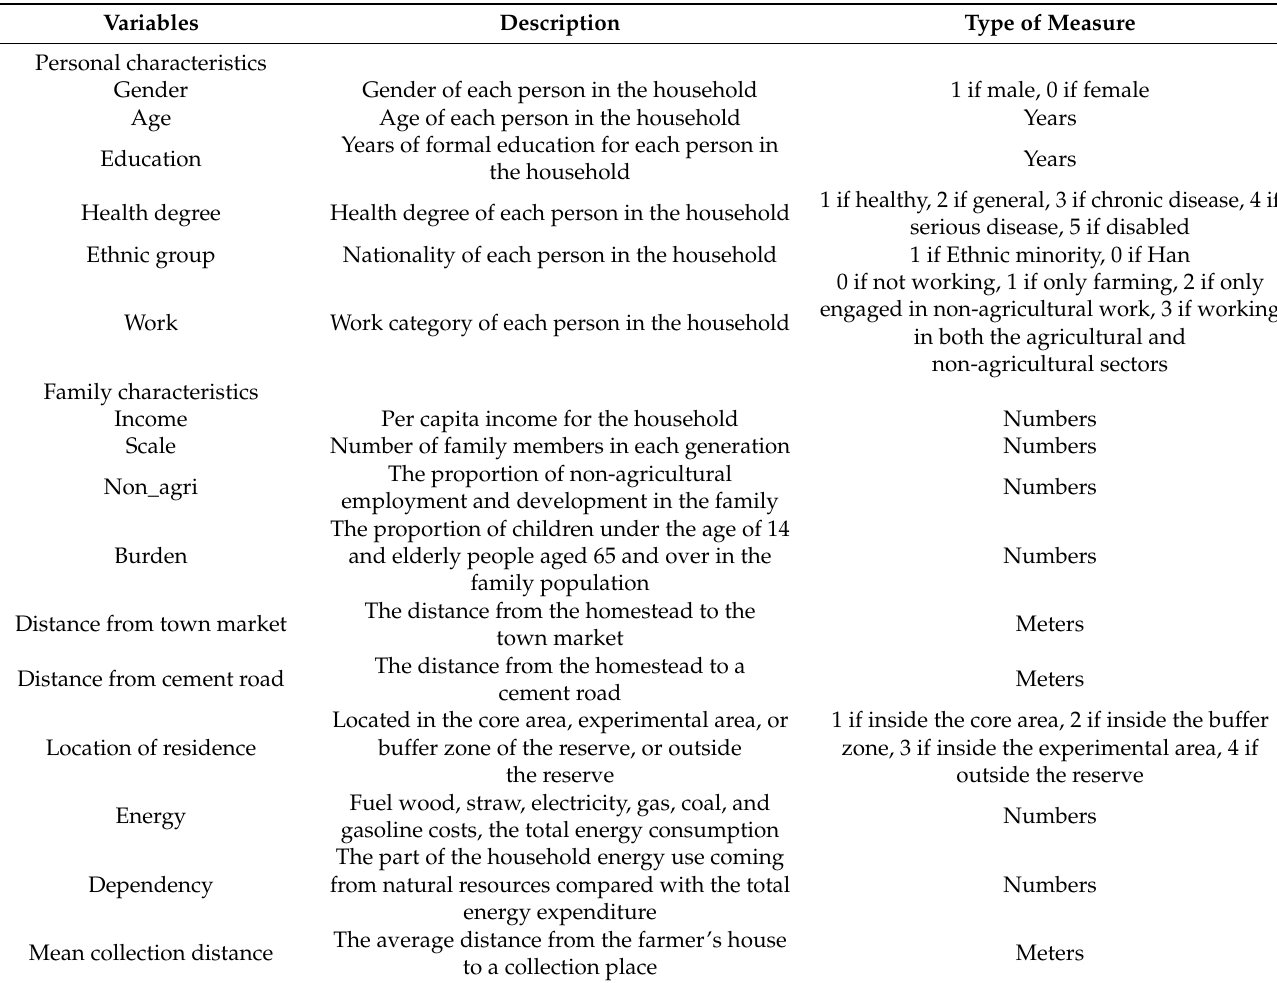
Table 3. Description of the independent variables specified in the Probit/SUR-Probit